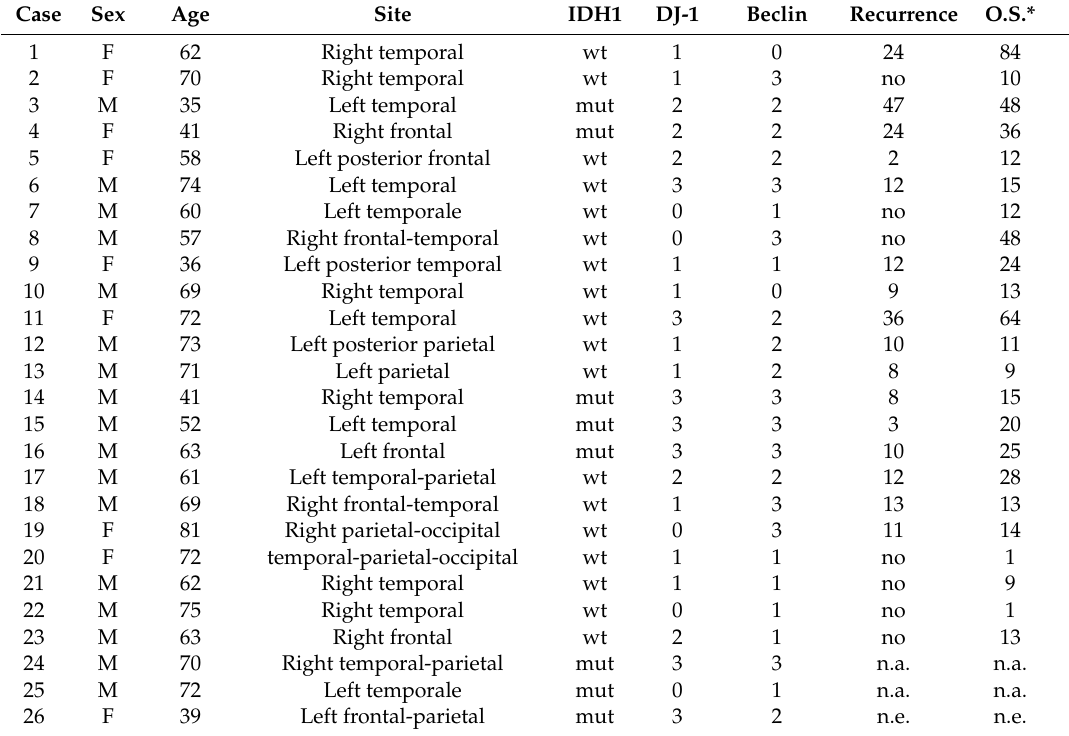
Table 1. Clinico-patohologic features of the